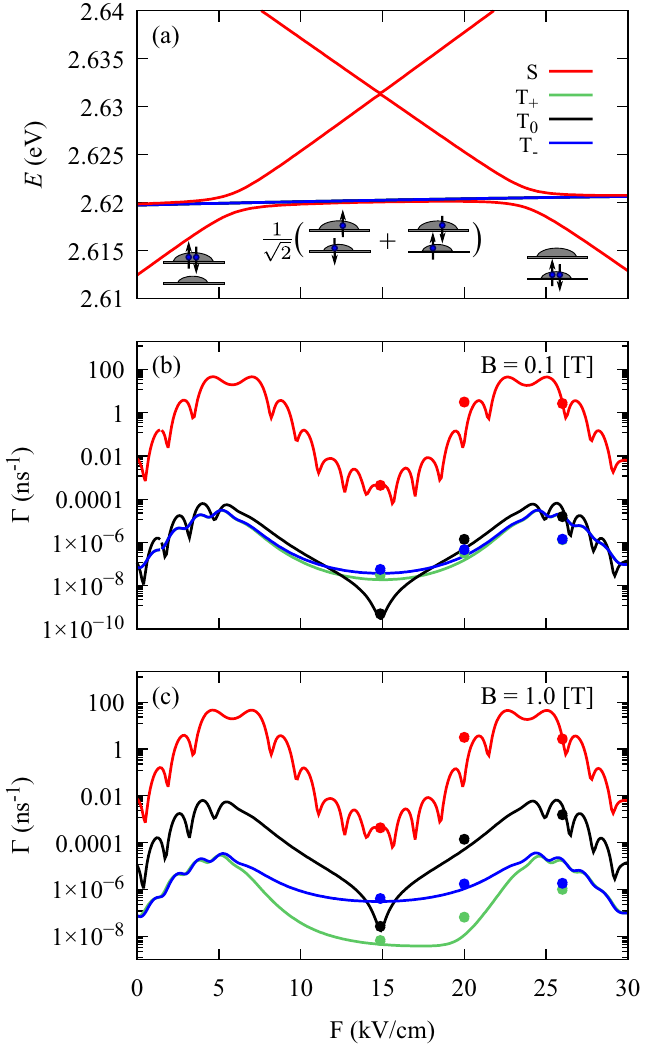
Figure 2. ( a ) Two-electron energy levels as a function of electric field. The sketches present (approximate) spins projections and occupations in the lowest singlet state. ( b , c ) Phonon-assisted transition rates to the lowest singlet state from: the first upper singlet (red solid line), triplet T (green solid line), T 0 (black solid line), T + 0 K. The points in ( b , c ) correspond to CI calculations in the extended basis = of 24 electron